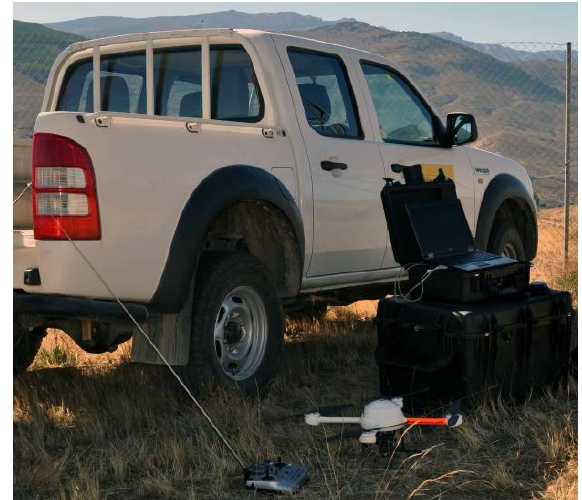
Figure 1. Microdrone UAV, base station and hand held remote control transmitter